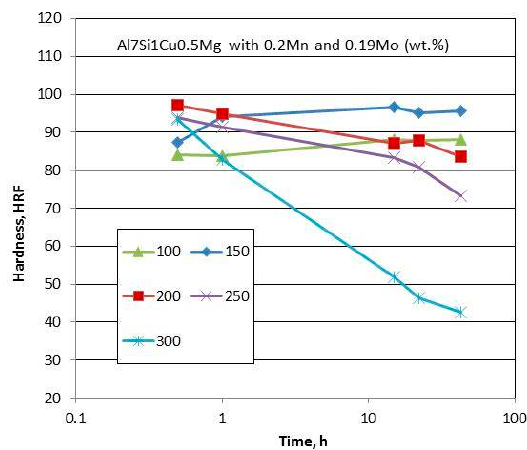
Figure 24. Hardness changes during aging of the Al7Si1Cu0.5Mg alloy modified with addition of 0.20 wt.% Mn and 0.19 wt.% Mo. Solution treatment included heating at 510 °C for 0.5 h followed by 4.5 h at 525 °C and water quench [111].